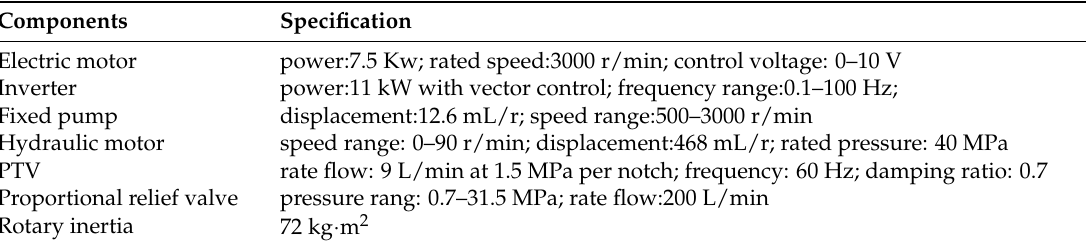
Figure 4. Experimental system. ( a ) A view of the experimental system; ( b ) Loading system.